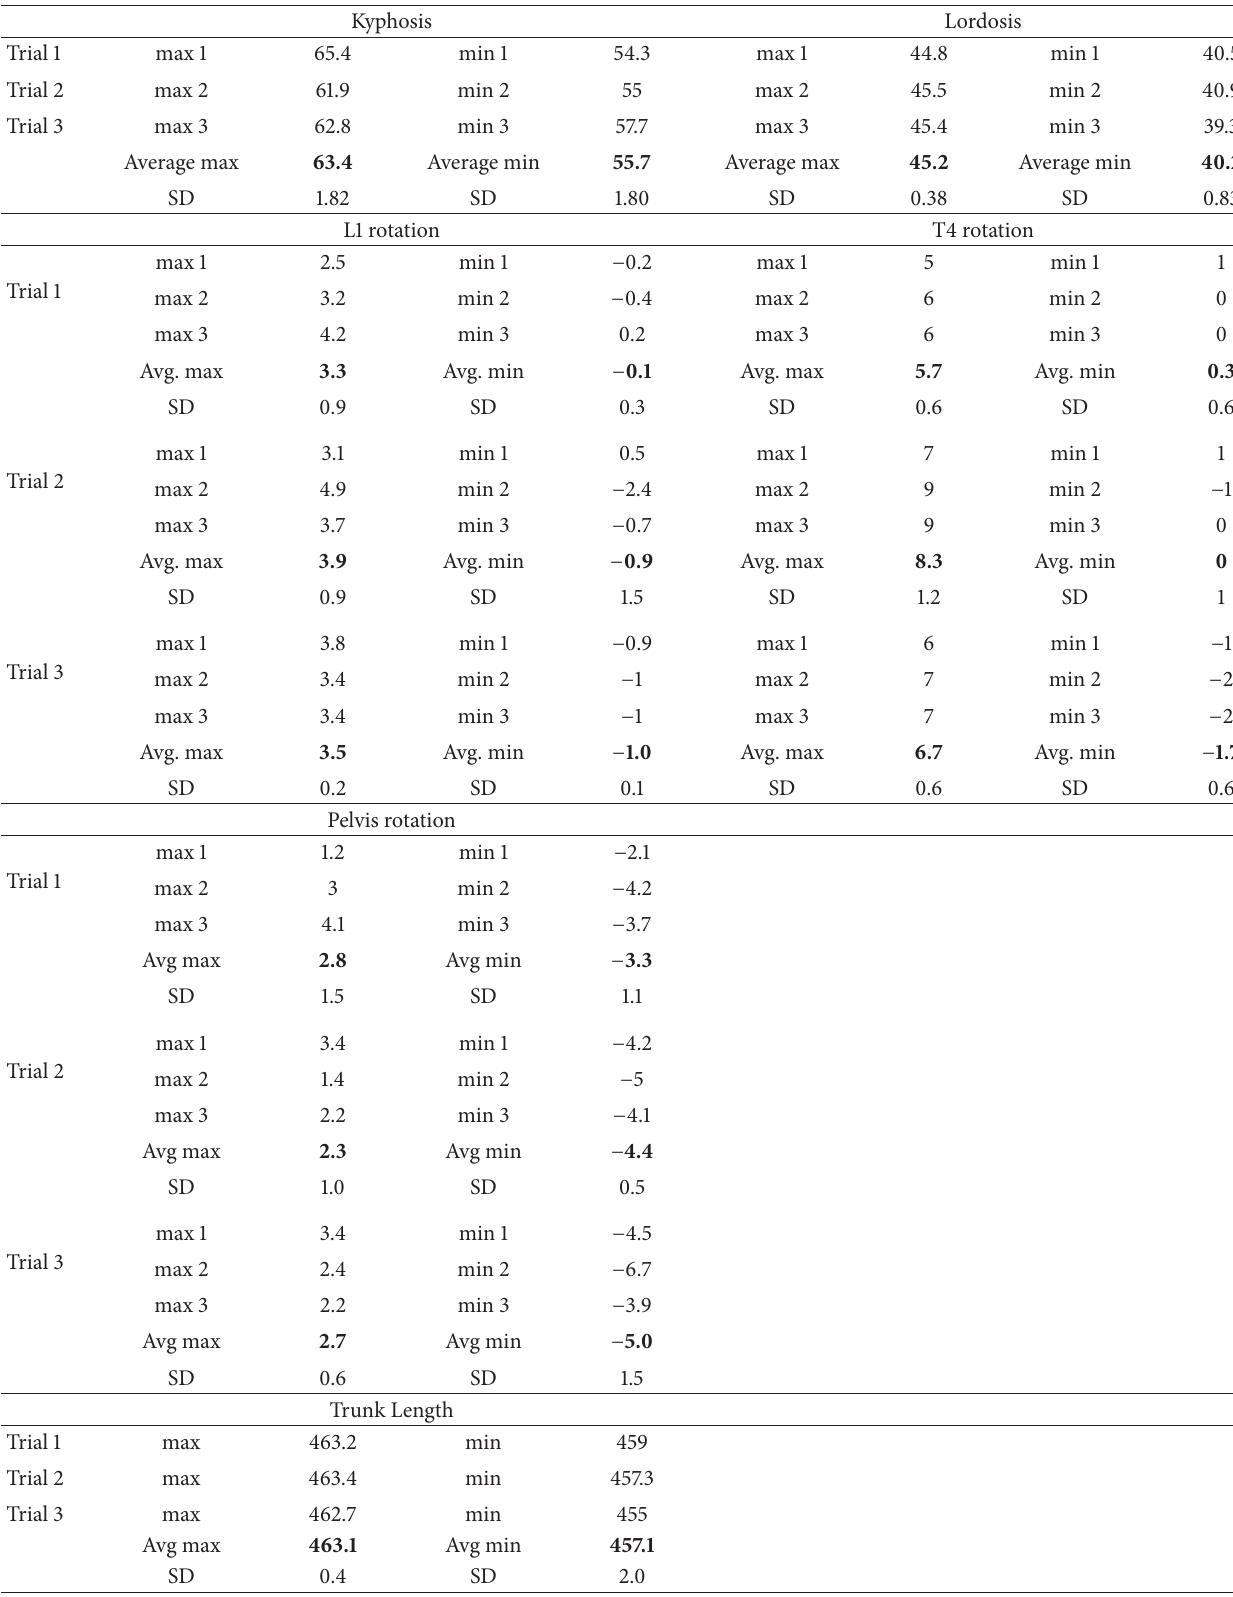
Table 1: Raw data collected from one subject for all 3